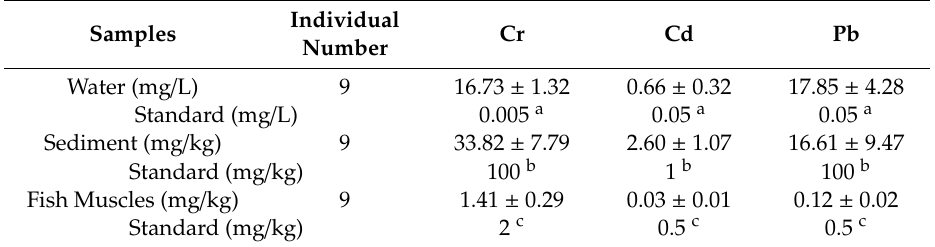
Table 5. Heavy metal concentrations in the water, sediment and fish muscles from the landfill reservoirs (mean ± standard deviation; n =